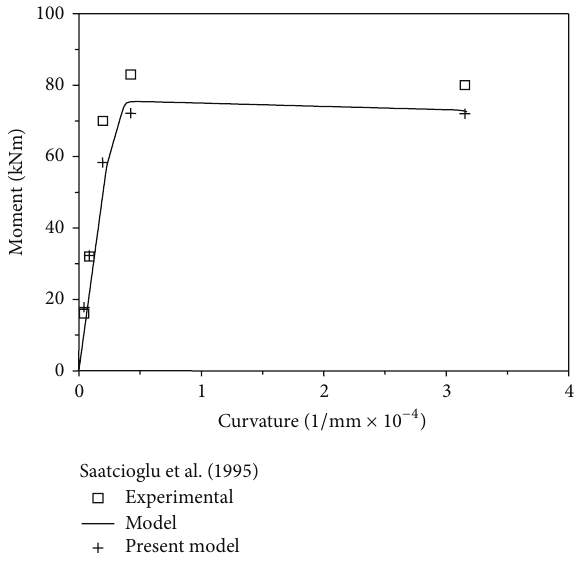
Figure 9: Comparison of theoretical and experimental